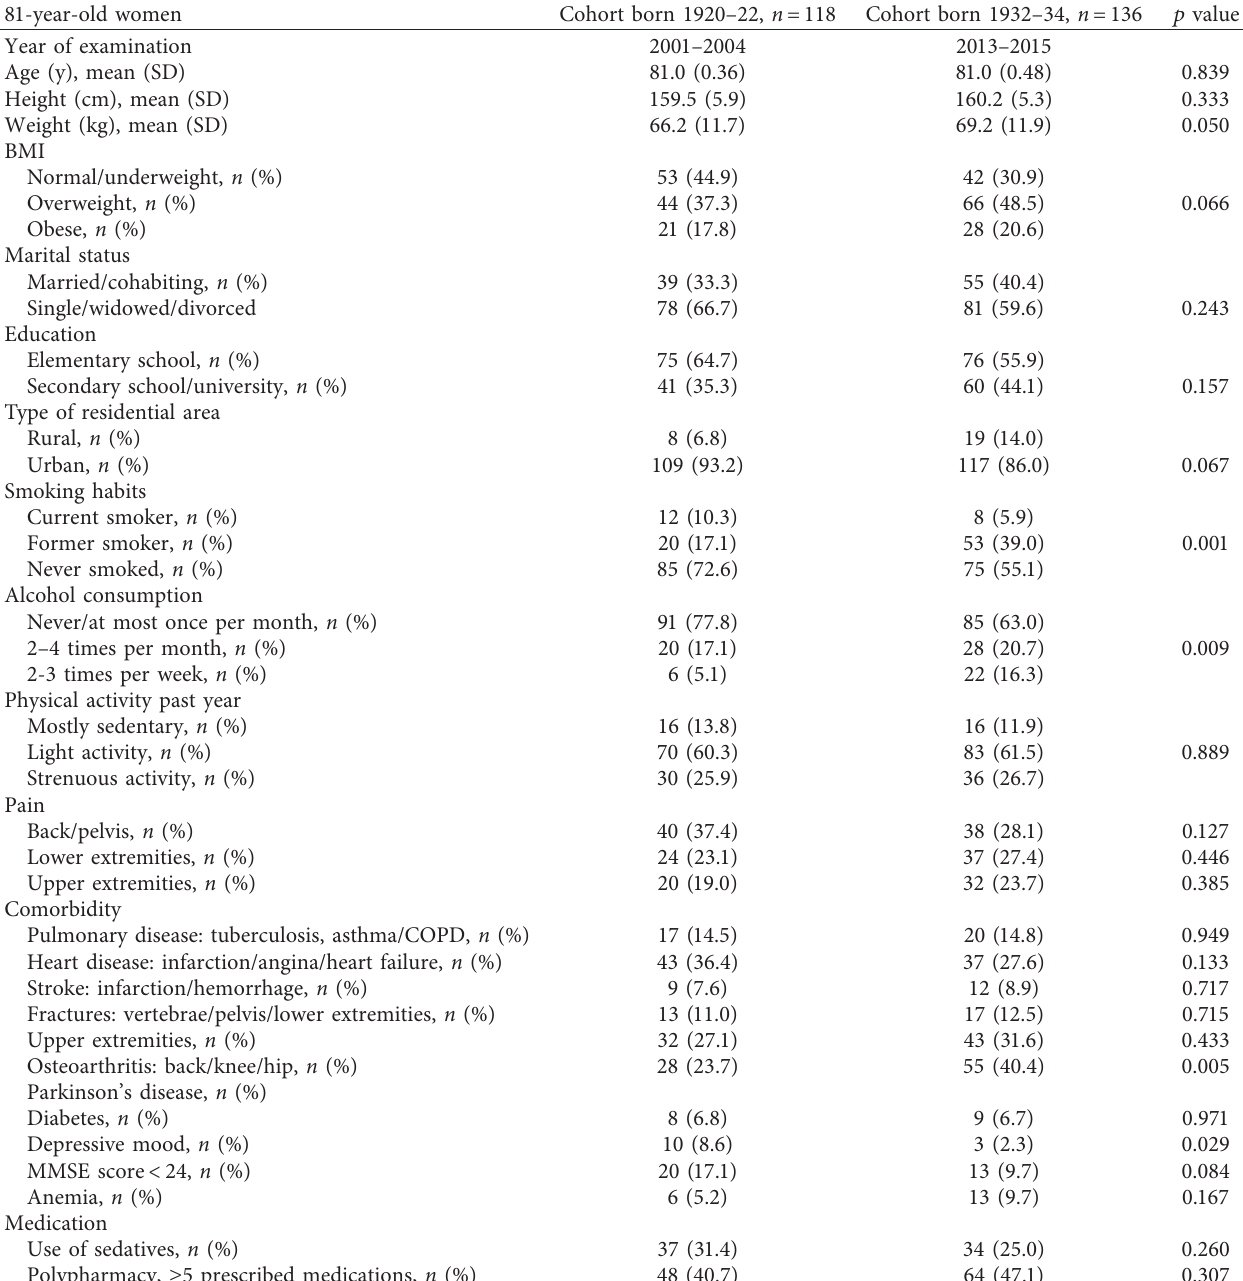
Table 2: Description of the 81-year-old women in the birth cohorts 1920–22 and 1932–34 from the Good Aging in Sk˚ane general population